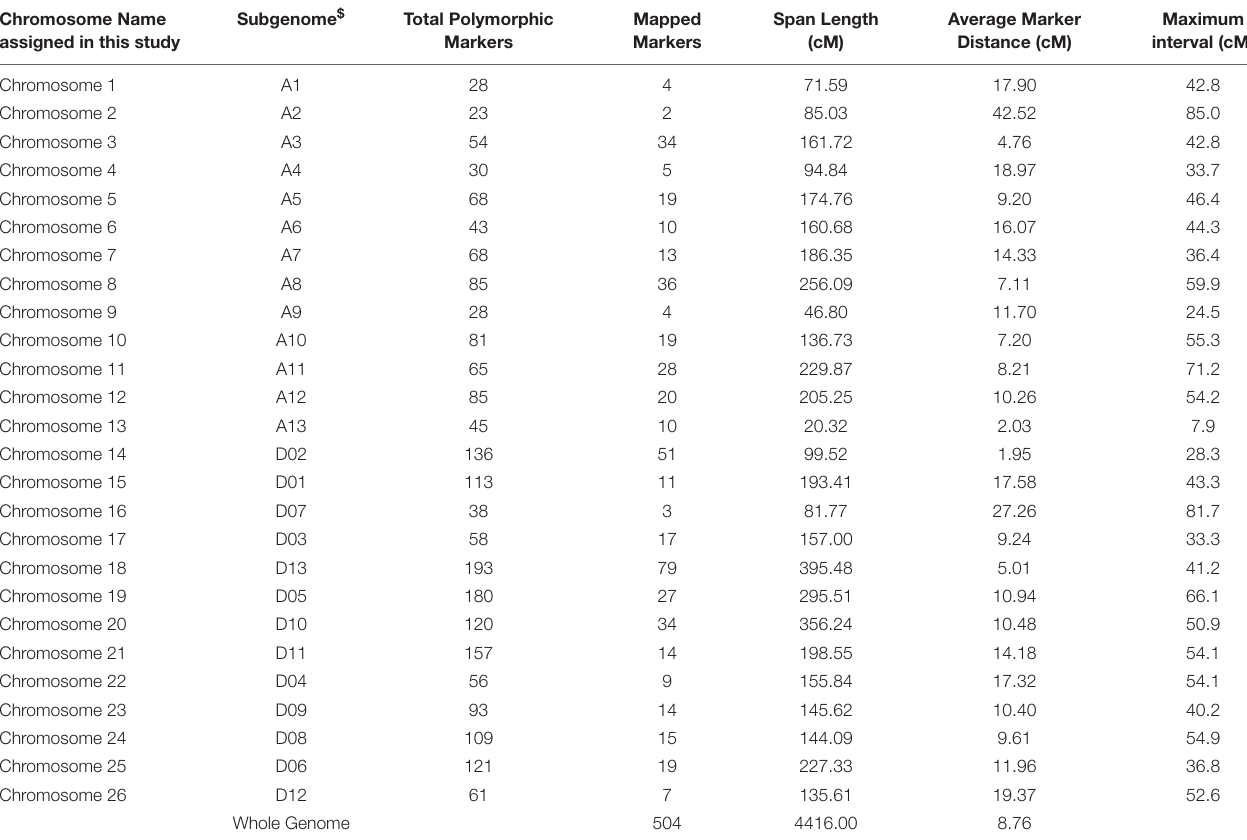
TABLE 4 | Details on the distribution of markers on different cotton chromosomes and their intervals, total span length of each chromosome and average marker distance obtained from the linkage analysis of the intra-specific cross genetic map developed in this study using the RILs derived from MCU5 and